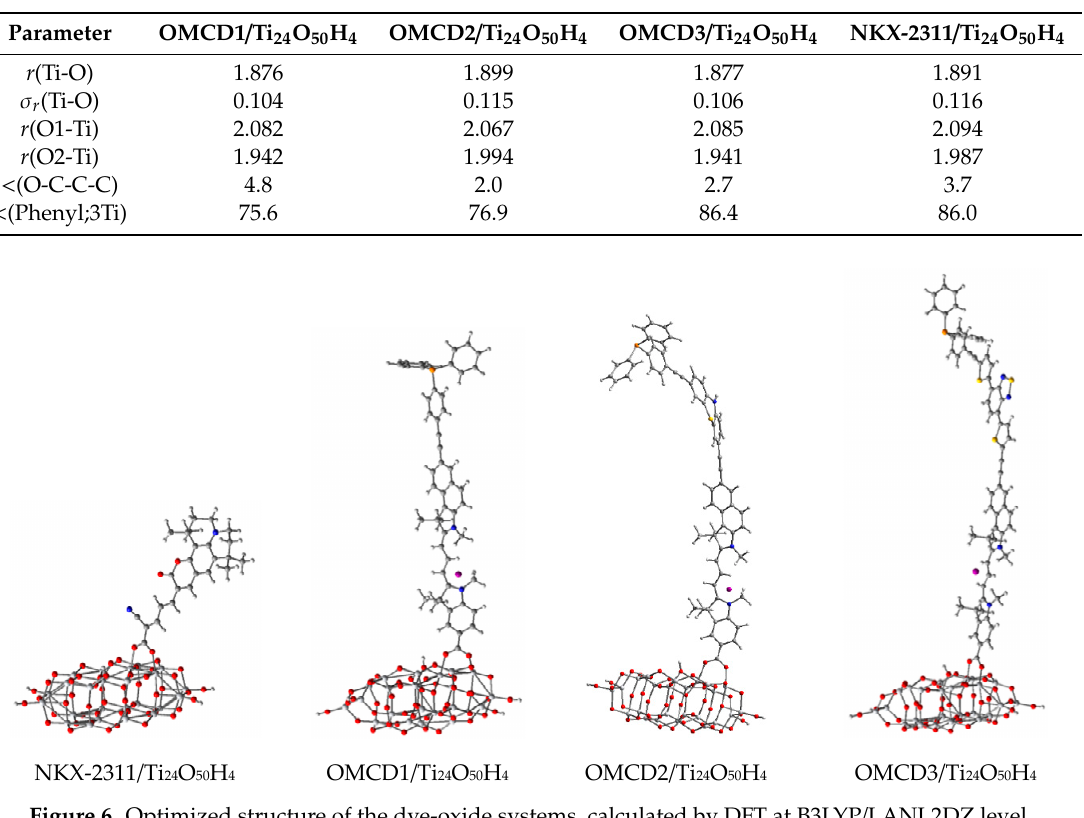
Figure 6. Optimized structure of the dye-oxide systems, calculated by DFT at B3LYP / LANL2DZ level. Colour coding: C—grey, O—red, N—blue, S—yellow, P—orange, I—purple, Ti—light grey, H—light grey small